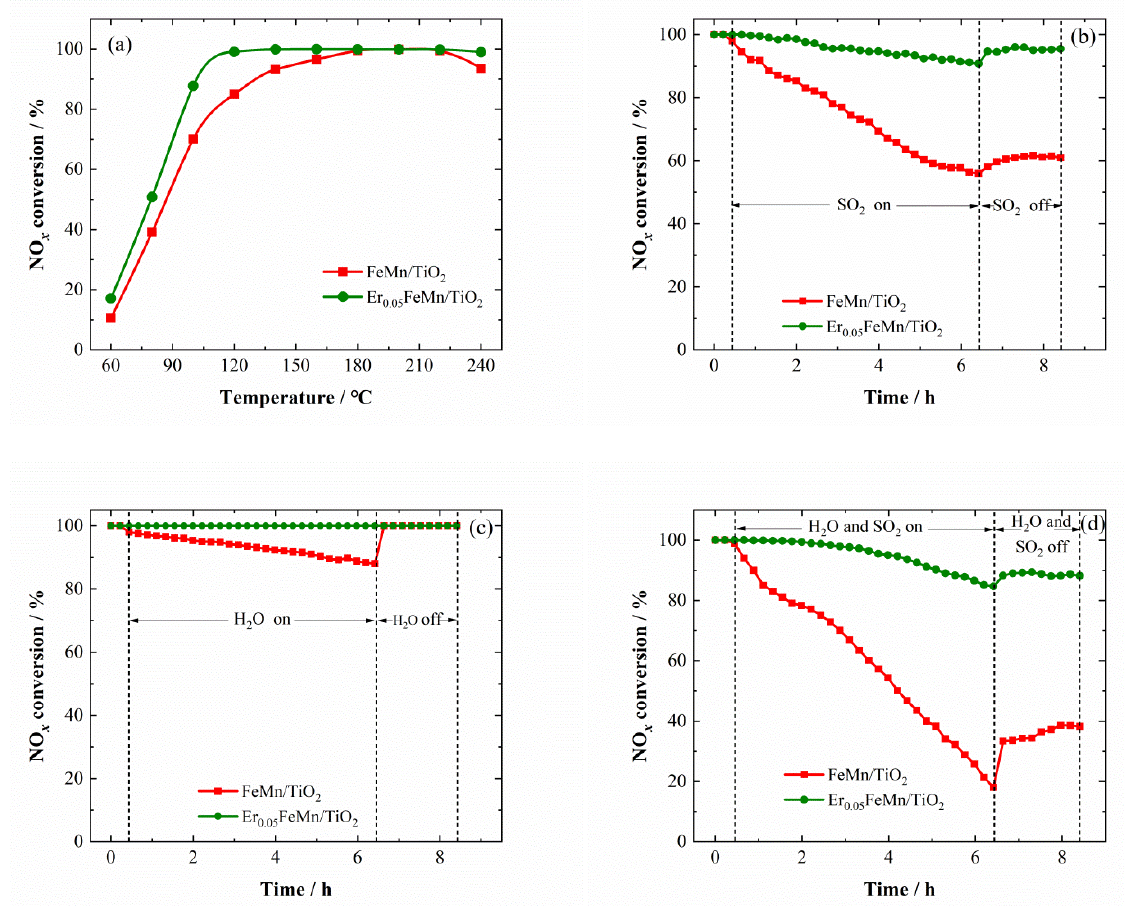
Figure 1. NO x conversion ( a ), resistance to sulfur poisoning test ( b ), resistance to water vapor poisoning test ( c ), resistance to water vapor and sulfur poisoning test ( d ) during the NH 3 -SCR reaction over FeMn/TiO 2 and Er 0.05 FeMn/TiO 2 catalysts. (Reaction conditions: 1 mL catalyst, [NO] = [NH 3 ] = 500 ppm, [O 2 ] = 5 vol.%, [SO 2 ] = 100 ppm (when used), 5% H 2 O (when used), balanced with N 2 , GSHV = 30,000 h − 1